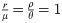
Estimated demographic history with no selfing or seed banking.Estimated demographic history using four simulated sequences of 30 Mb under a saw-tooth scenario with 10 replicates. Mutation and recombination rates (respectively μ and r) are set to 2.5 × 10−8 per generation per bp. Therefore rμ=ρθ=1. The simulated demographic history is represented in black. a) Demographic history estimated by eSMC (red). b) Demographic history estimated by MSMC (purple). c) Demographic history estimated by MSMC2 (blue). d) Demographic history estimated by PSMC’ (orange).